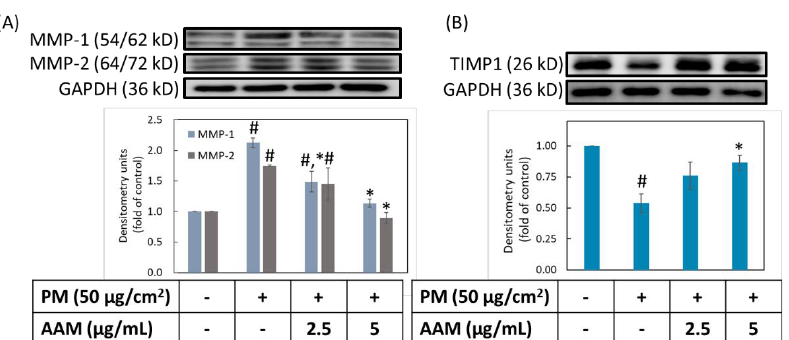
Figure 6. Effect of AAM on PM-induced aging protein expressions in HaCaT cells. MMP-1 and MMP-2 ( A ), TIMP1 ( B ). Data were from three independent experiments. Value are mean ± SD ( n = 3). # Significantly different from control group ( p < 0.05); * Significantly different from PM treatment alone ( p < 0.05).